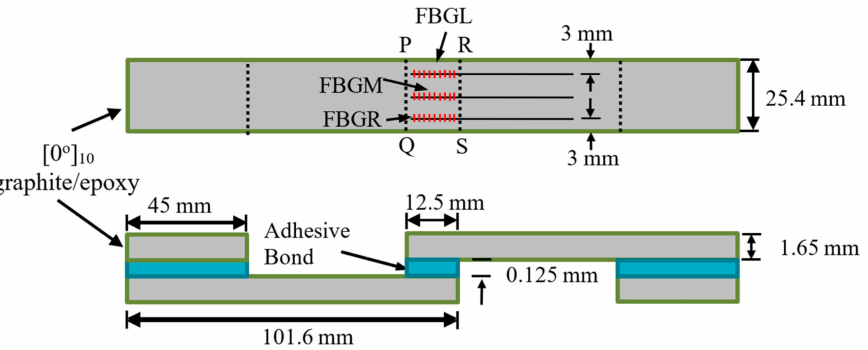
Figure 2. Dimensions and layout of the single lap joint